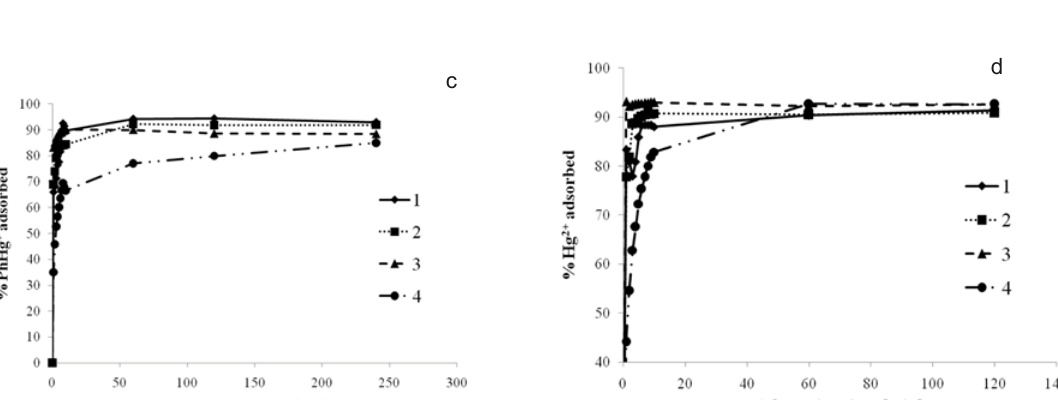
sediment Al and Fe decreased adsorption; R ranged from -0.63 to -0.90 and from -0.65 to -0.86. Competitive occupation of adsorption sites by aluminum or iron ions is